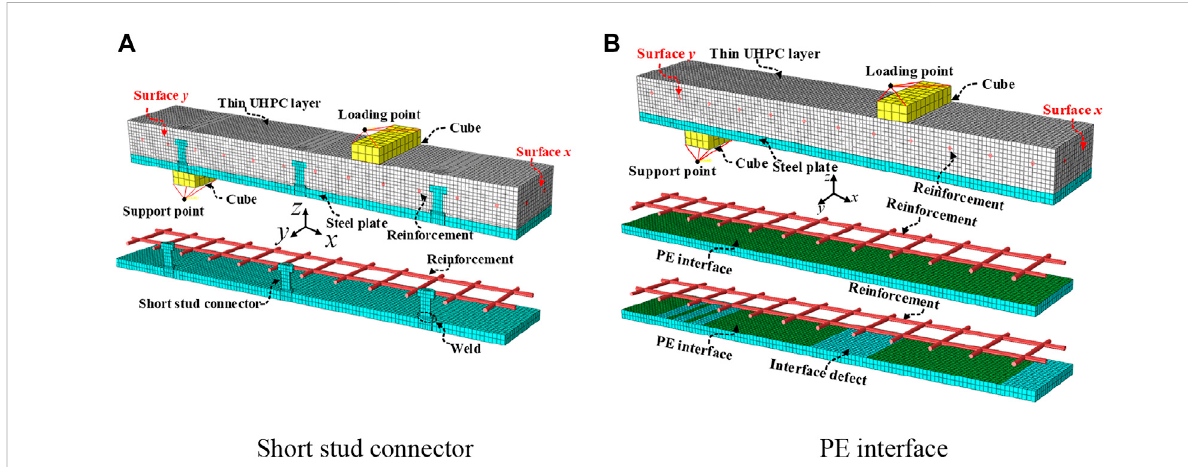
FIGURE 11 Modeling information. (A) Short stud connector. (B) PE interface.